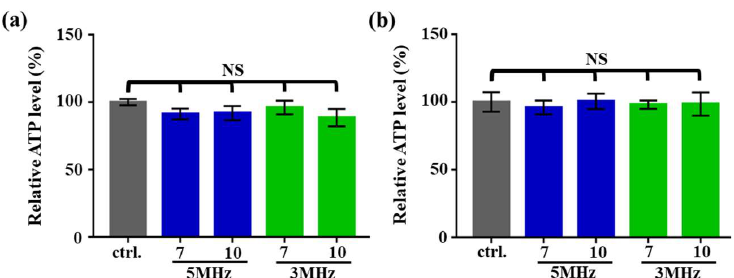
Figure 4. Comparison of the relative ATP levels (%) of ( a ) the PC-3 cancer cells and ( b ) the SK-BR-3 cancer cells treated with the optically induced dielectrophoresis (ODEP) field under varied electric conditions (voltage magnitude and frequency—7 and 10 Vpp and 3 and 5 MHz, respectively) [NS—No significant difference ( p > 0.05)].